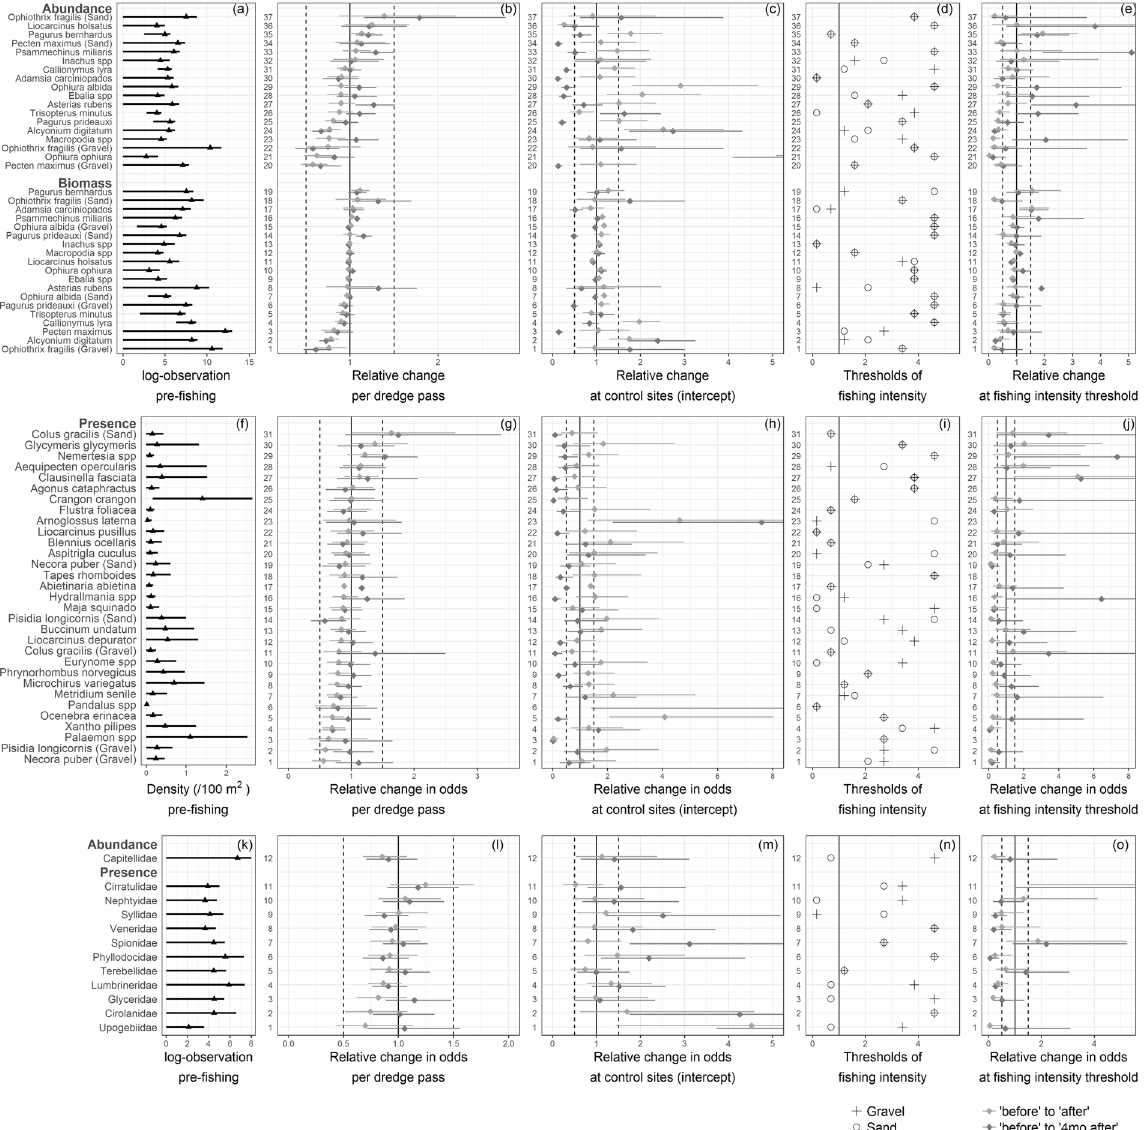
Figure 3. Comparison of the effect size of fishing intensity (FI) vs natural time variation on the abundance and biomass of epifaunal taxa (top row, a–e ), the presence of epifaunal taxa (midle row, f–j ) and the abundance and presence of infaunal taxa (bottom row, k–o ). Some taxa have a different response in sand and gravel as indicated. For each row, the first panel ( a,f,k ) is the pre-fishing observed estimate ± standard deviation (density is given for data analyzed as presence/absence only); densities and biomasses are log-transformed in the top and bottom panels using log(x100), with original data in number or g/100 m 2 . The second panels ( b,g,l ) are the relative changes due to the interaction between FI and survey time and the third panels ( c,h,m ) the survey effect alone, both from the GLMM outputs using continuous FI in the predictor variables. The fourth panels ( d,i,n ) are the taxon-specific FI thresholds and the fifth panels ( e,j,o ) the relative change at those thresholds as estimated from the GLMMs outputs using the categorized FI. Note that for presence this is the change in odds (i.e probability of presence compared to probability of absence). Light grey = before to after fishing (March to May), dark grey = before to four months after fishing (March to September). Estimates shown in the second, third and fifth panels are the effect sizes, exp( β ) from eq1, with 90% confidence interval ( α = 0.1). Abundance was modeled with Poisson or negative binomial, biomass with gamma distributions and presence with binomial (log-log link) distributions GLMMs. The vertical dash lines are ± 0.5. 1 means no change, ± 0.5 means ± 50% abundance, biomass or odds. Missing values in (e,j,o) are taxa for which the model failed to